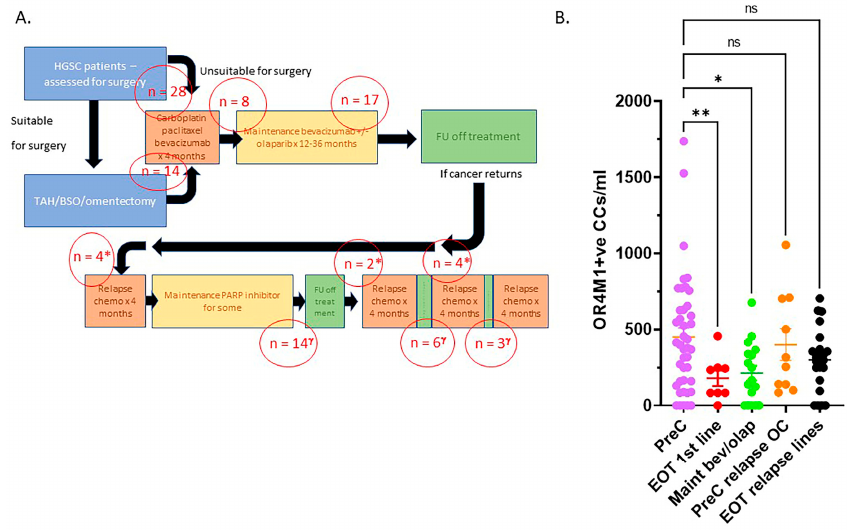
Figure 8. Cancer-associated circulating cells (CCs) from liquid blood biopsies donated by six different serous OvCa patients probed with OR4M1/TLR4. ( A – C ) Samples showing the expression of OR4M1 (Ch02—green) in the circulating tumour cells of patients presenting with high grade serous ovarian cancer; ( A ) represents stage IV, ( B ) stage IV and ( C ) stage III; ( D – F ) Expression of TLR4 in CCs; here, Ch02 represents TLR4 (green); ( D ) is representative of stage II, ( E ) stage III and ( F) stage IV. Ch01, Bright Field; Ch02, OR4M1/TLR4 (green); Ch04, CD45—white blood cell exclusion marker (brown); Ch05, DRAQ5—cell nuclear stain (red); Ch02/05, overlay of Ch02 with Ch05. Stages (I–IV) refer to the severity of OvCa metastasis according to the International Federation of Gynaecology and Obstetrics (FIGO) staging system.